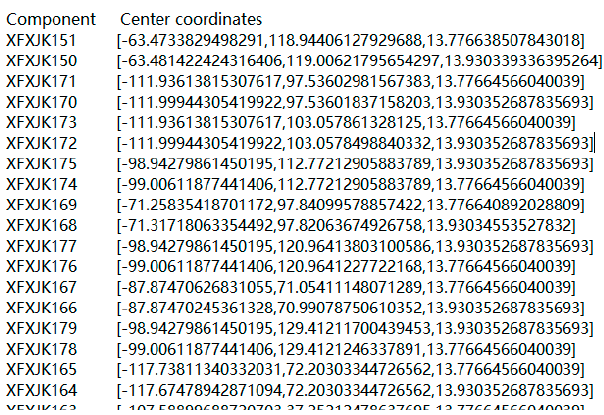
Figure 10. Parsed component coordinate information.